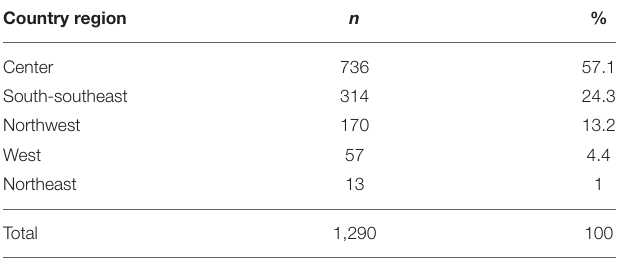
TABLE 1 | Students’ distribution by country region. Country